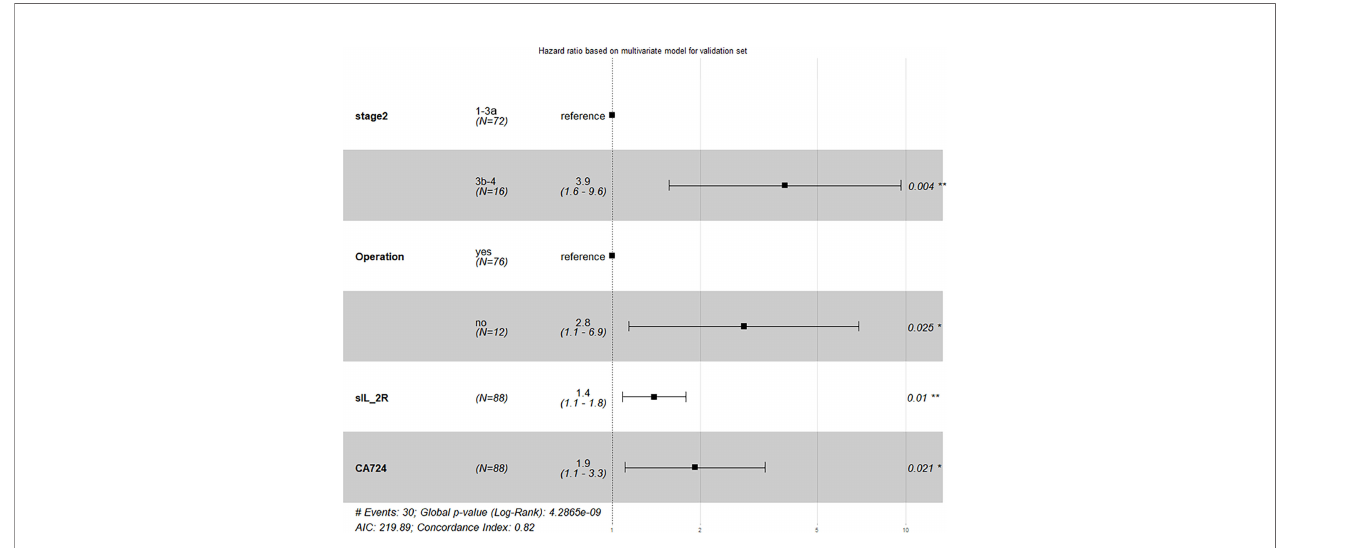
FIGURE 4 | Result of external validation based on validation dataset ( Stage 2 , TNM stage; Operation , operation